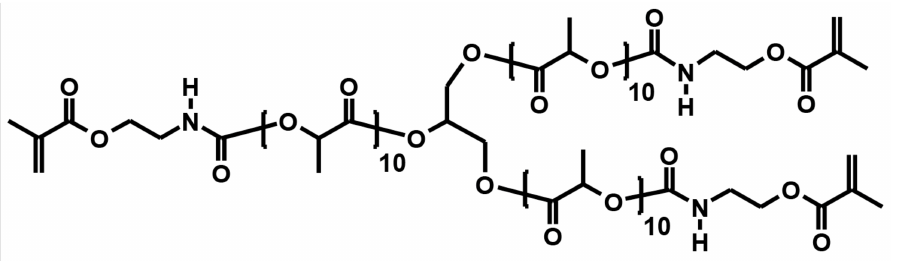
Figure 6. Structural formula of oligoester-urethane methacrylate (the main component of